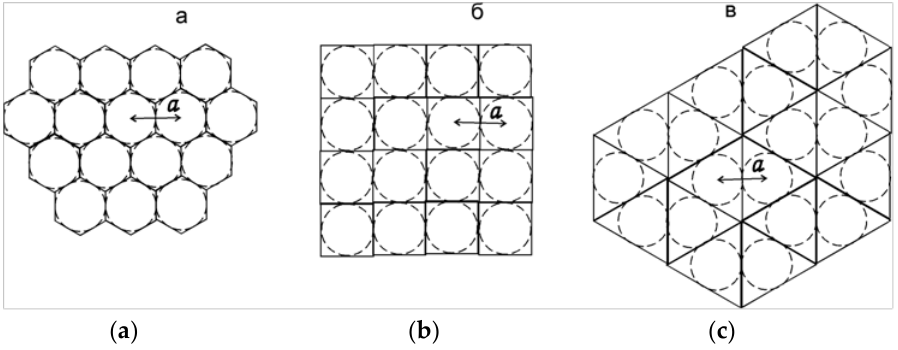
Figure 2. The two-dimensional lattices: ( a ) hexagonal,( b ) square, ( c ) triangular.